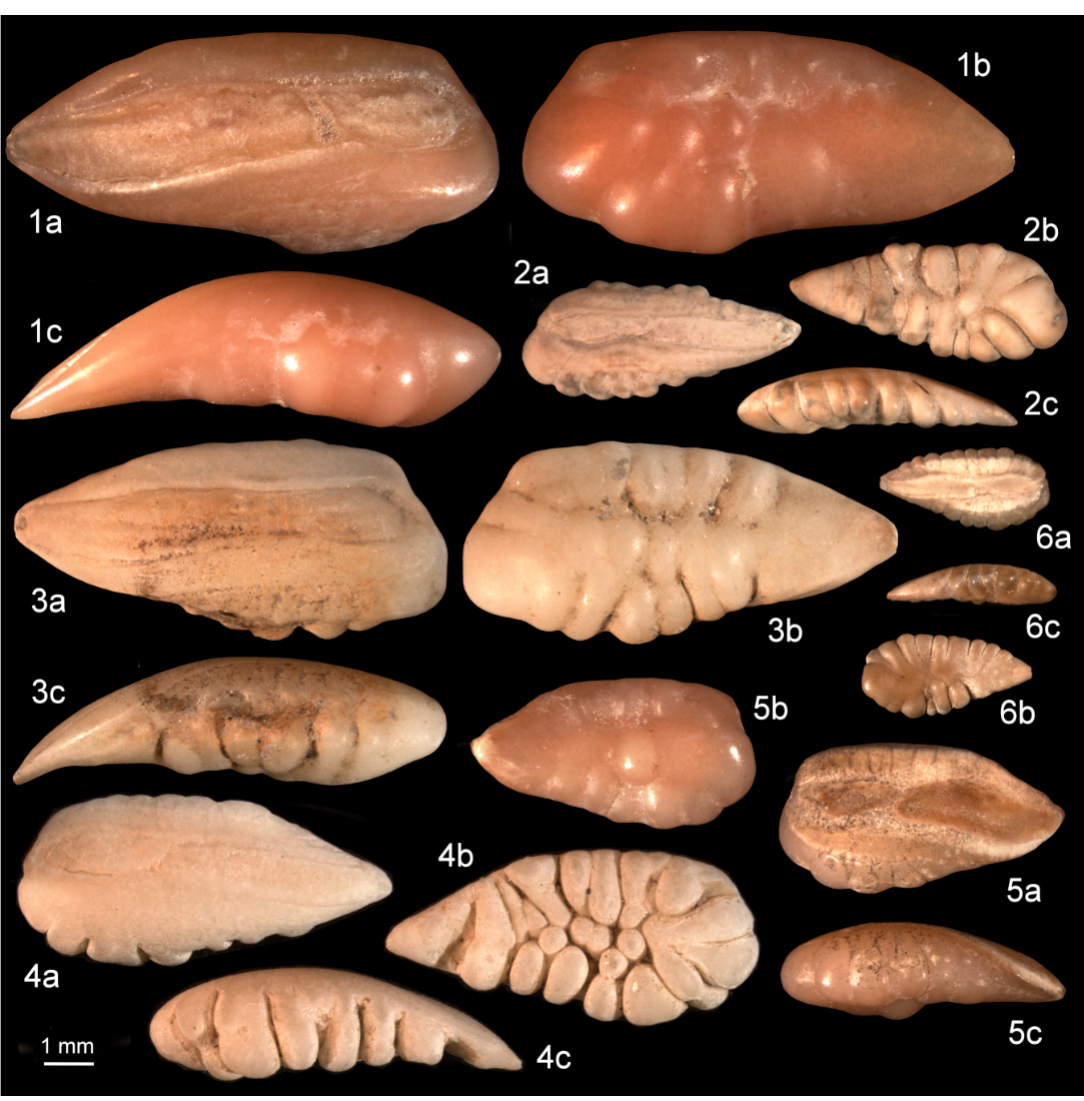
Figure 8. Trisopterine otoliths from the Ría de Arosa, Galicia, Northwestern